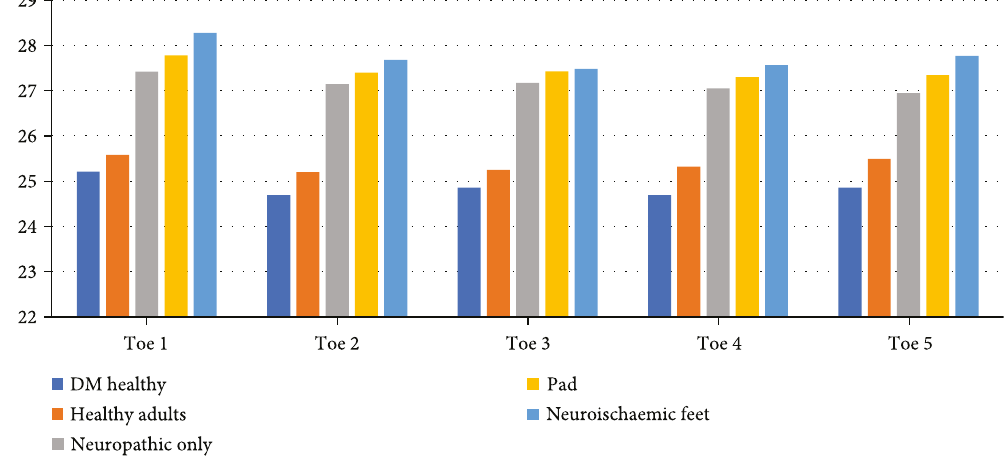
Figure 2: Toe temperature distribution.